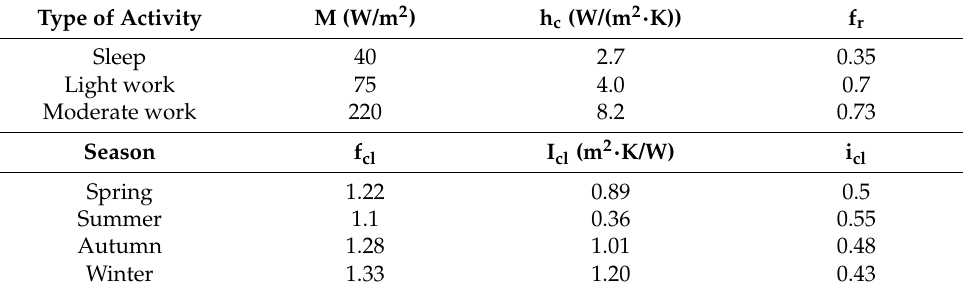
Table 1. Parameters used within the